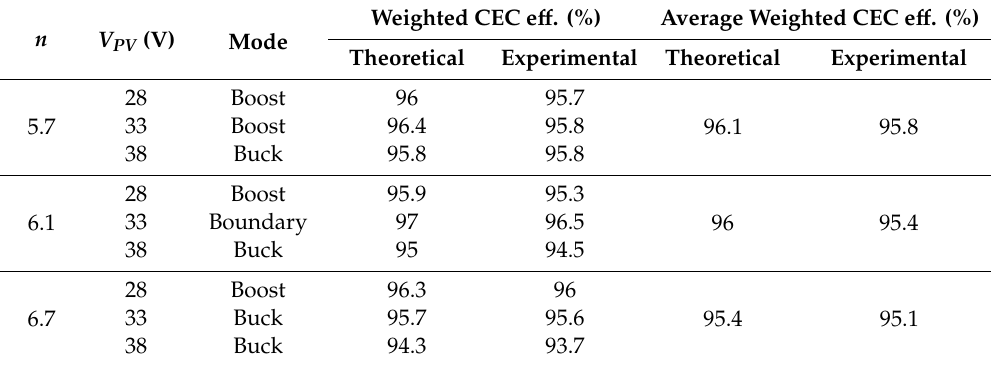
Table 4. Evaluation of the transformer turns ratio impact on weighted and average weighted California Energy Commission (CEC) e ffi